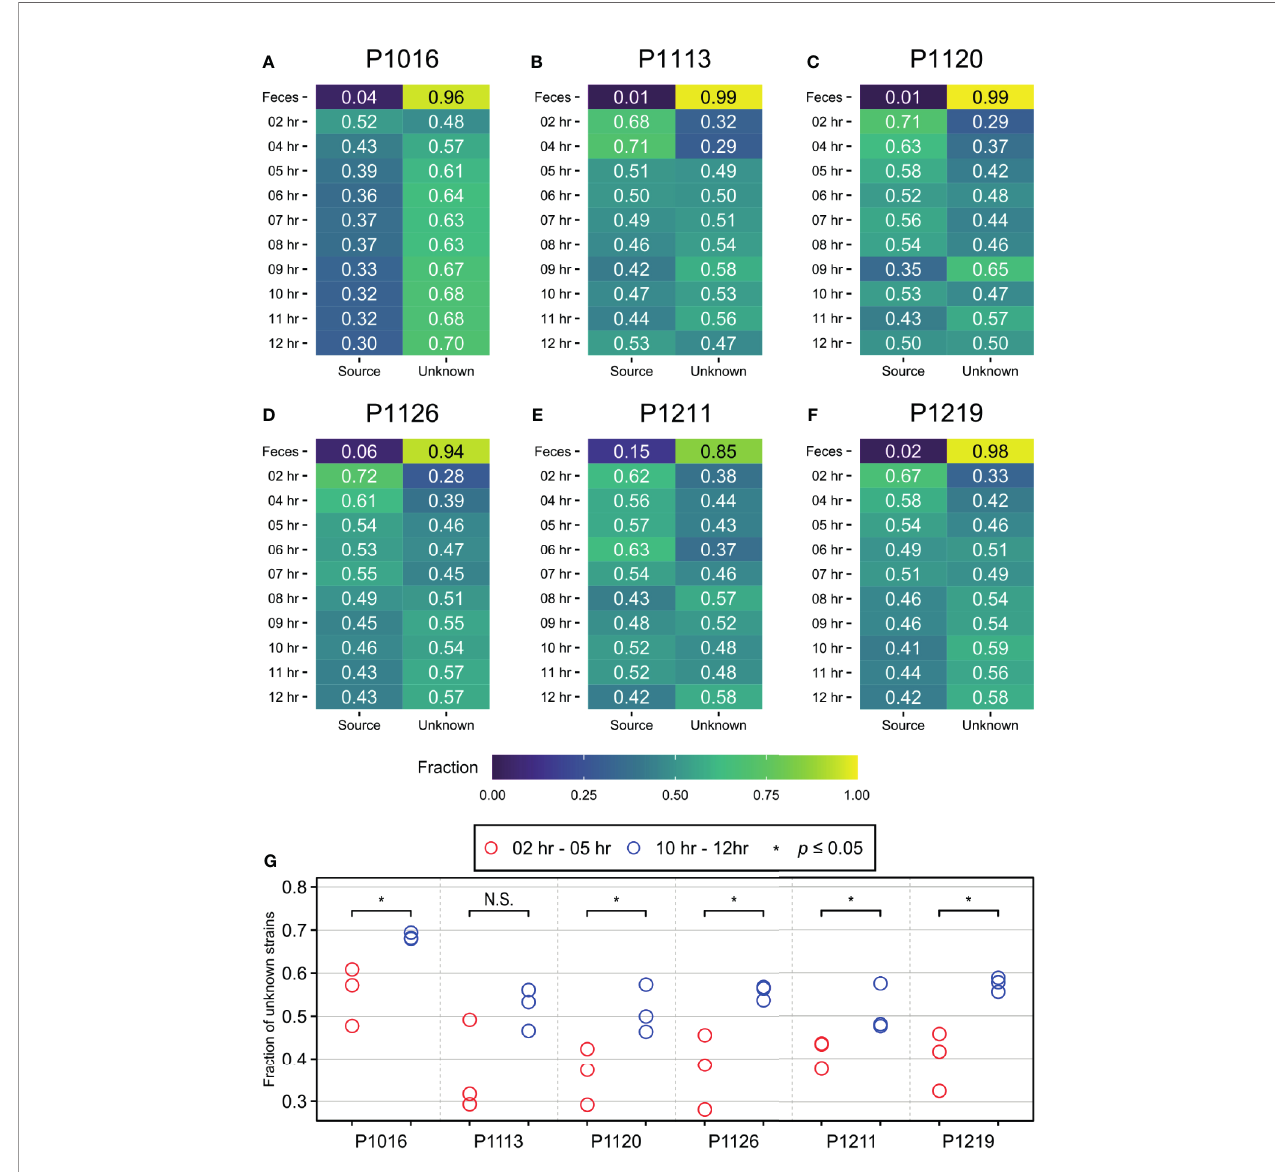
FIGURE 2 | SourceTracker2 analysis indicating that the population of novel bacterial strains not present at the initial time point increased throughout the induction period. (A – F) The microbiome observed at the initial time point is designated as the “ source ” . The proportions of species that originated from the source were then tracked throughout the induction period. The proportion of unknown strains increased gradually until approximately 7 to 8 h after the induction before being maintained. (G) Wilcoxon test was used to determine the signi fi cance between fi rst three time points (2, 4, 5 hours after induction) and the last three time points (10, 11, 12 hours after induction), and meaningful increase of an “ unknown ” microbiome was observed in fi ve of six animals. * denotes the p-value of the Wilcoxon test is less than 0.05. N.S., Not Signi fi